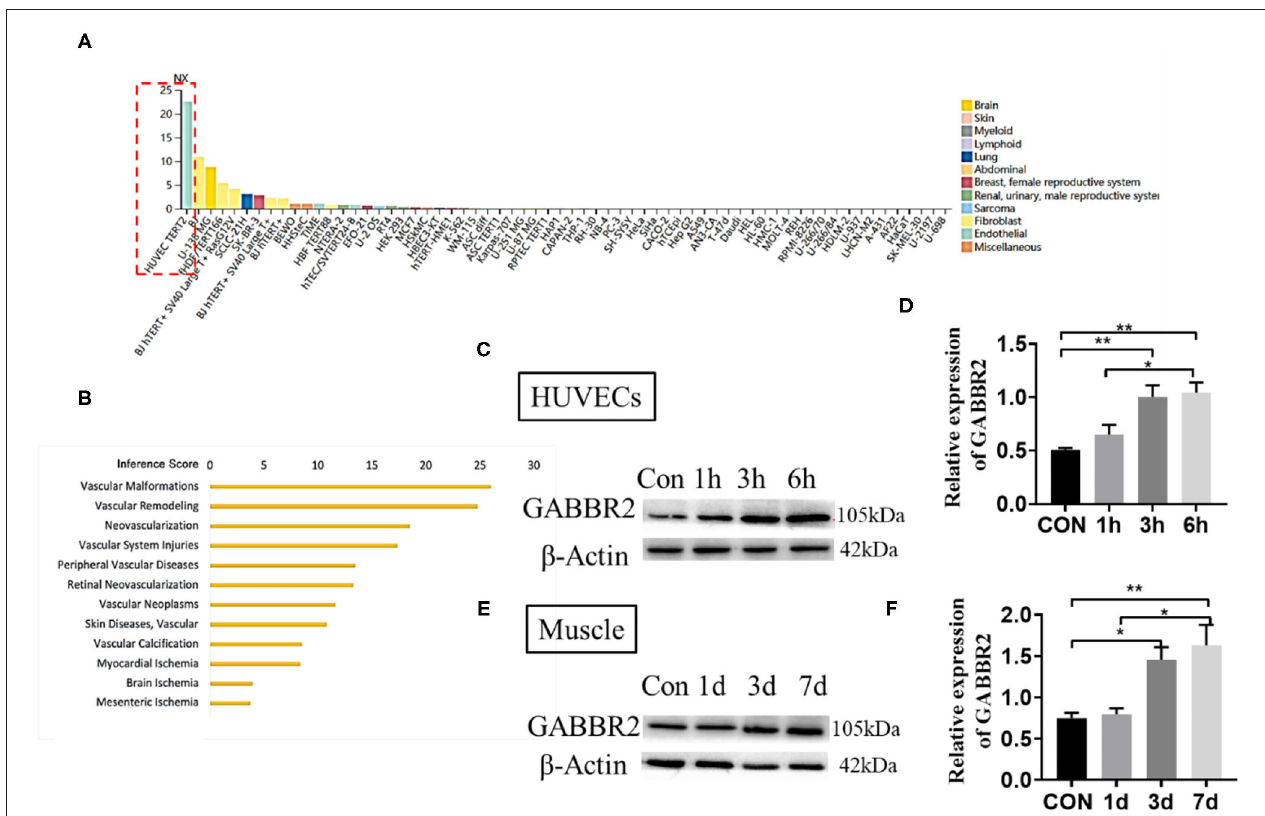
FIGURE 1 | Gamma-aminobutyric acid type B receptor subunit 2 (GABBR2) expression increased in hypoxia-treated endothelial cells in vitro and mouse ischemic hindlimb in vivo . (A) Prediction of an endothelial-specific expression of GABBR2 by RNA-seq data. (B) Re-speculation of the role of GABBR2 in angiogenesis. (C,D) Expression changes of GABBR2 in human umbilical vein endothelial cells (HUVECs) after hypoxia treatment for 1, 3, and 6h. (E,F) Expression changes of GABBR2 in the muscle of mouse ischemic hindlimb on days 1, 3, and 7. * p < 0.05; ** p < 0.01.